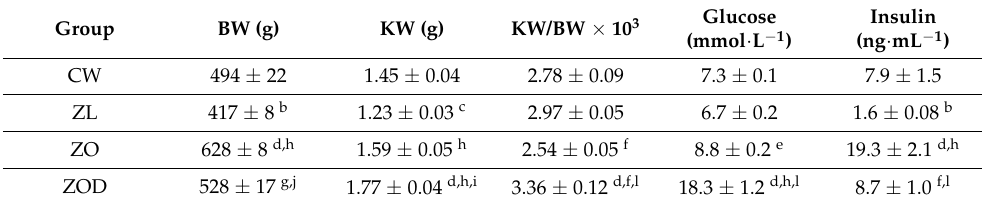
Table 1. General characteristics of the experimental